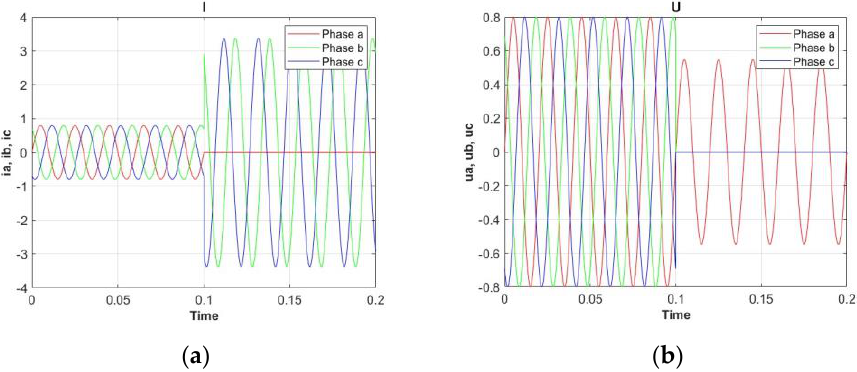
Figure 5. Images of changes in the signals of ( a ) currents and ( b ) voltages in the case of a short circuit between phases b and c on a neutral wire.